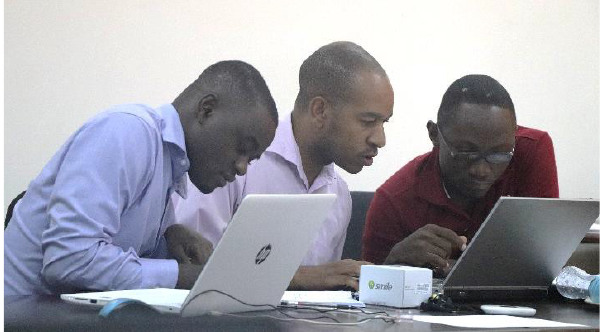
Figure 3. The participants of each university teamed up to discuss and plan the use of FOSS in their remote sensing